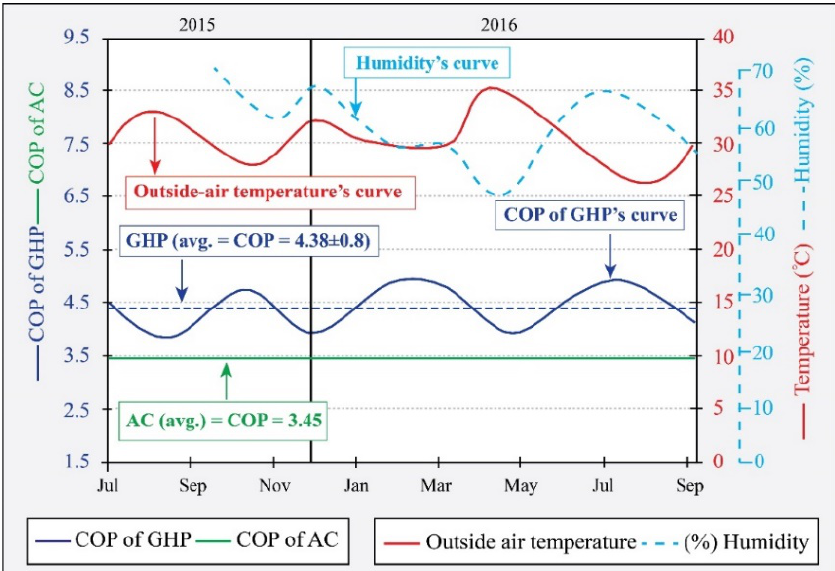
Figure 10. The comparison between COP value of GHP, AC and outside air temperature (ATM) when operating at 25 °C in long-term measurement (July 2015 to October 2016) and the comparison between value of COP of GHP and humidity when operating at 25 °C in long-term measurement (October 2015 to September 2016) at Parot Racha Building, Chulalongkorn University.